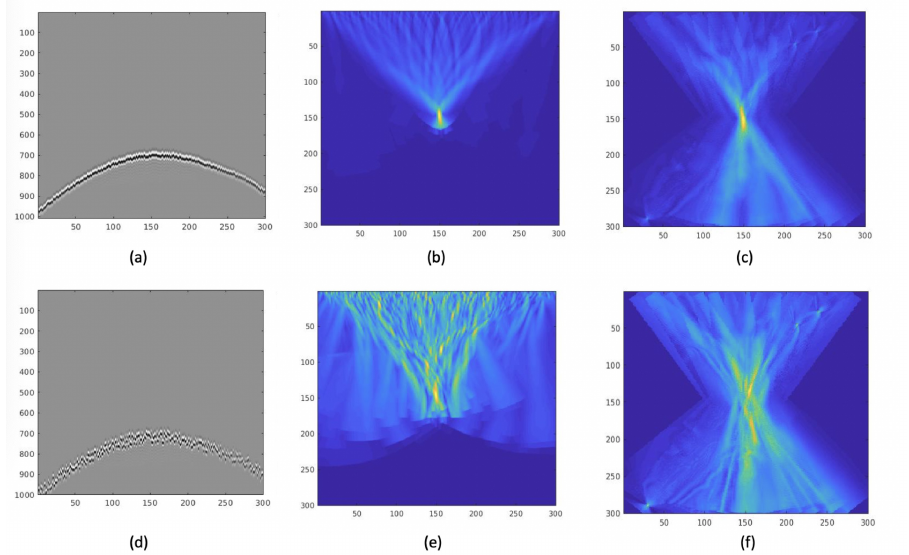
Figure 15. ( a ) Seismic data with random delays near 5 ms; ( b ) FDTD-TRI result; ( c ) GB-TRI result; ( d ) seismic data with five times larger random delays; ( e ) FDTD-TRI result; ( f ) GB-TRI result.